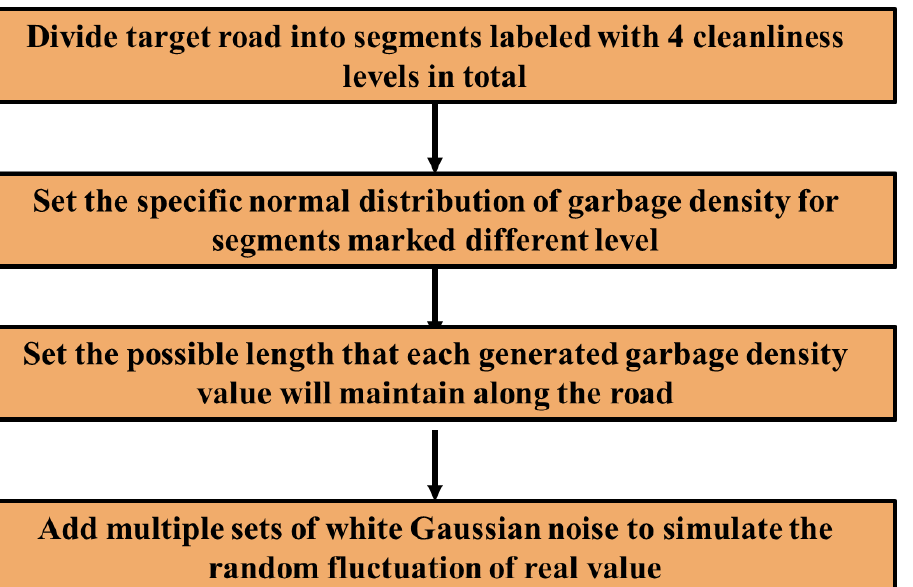
Figure 12. Modeling the process of the garbage distribution.